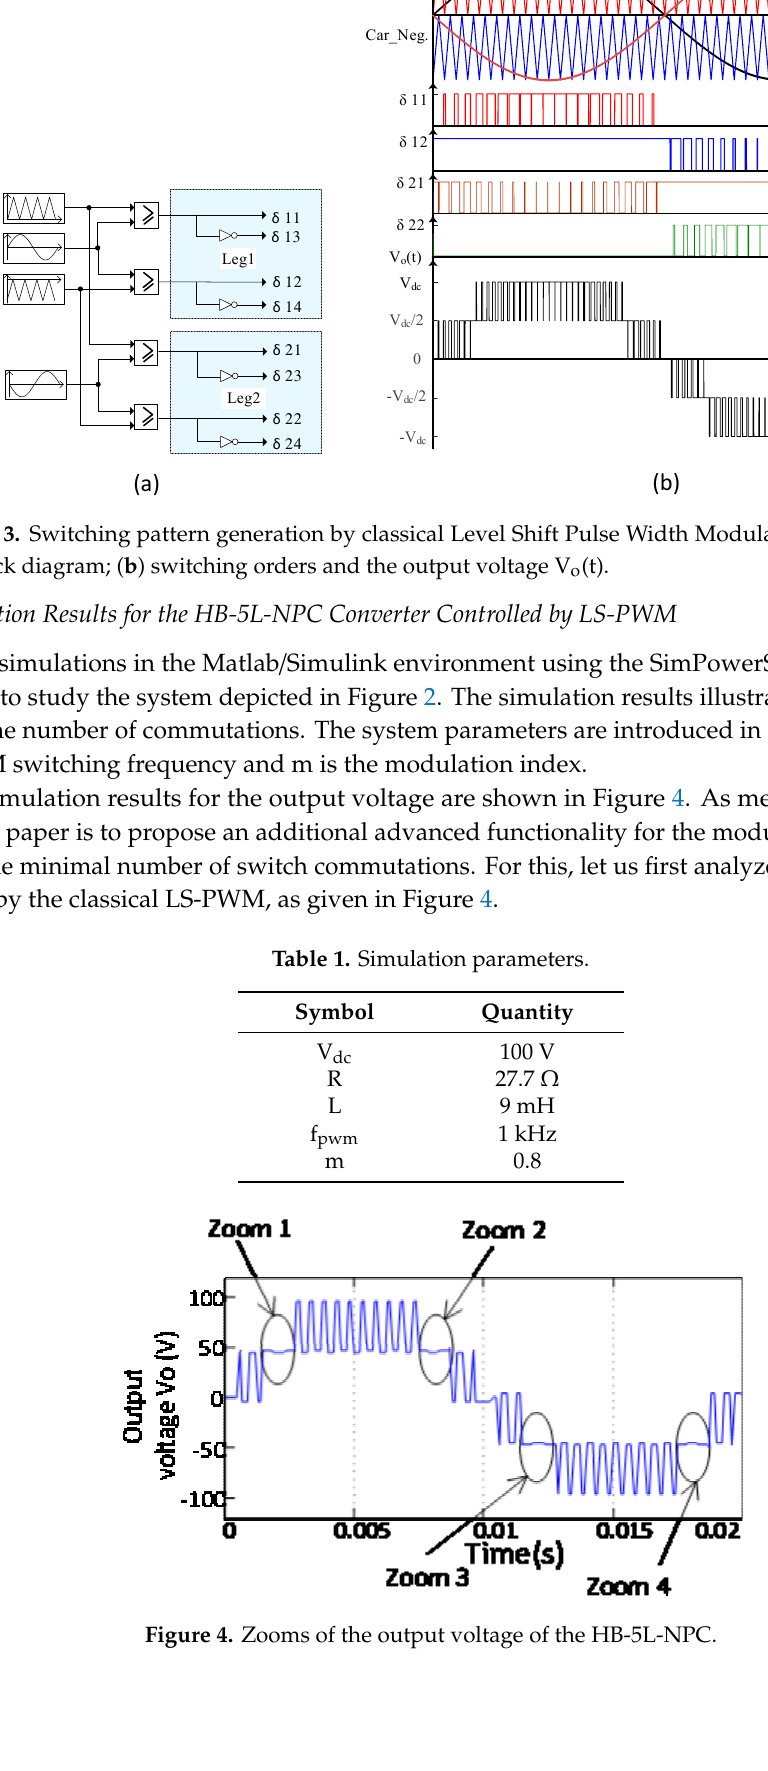
Figure 4. Zooms of the output voltage of the HB-5L-NPC. Table 1. Simulation parameters.